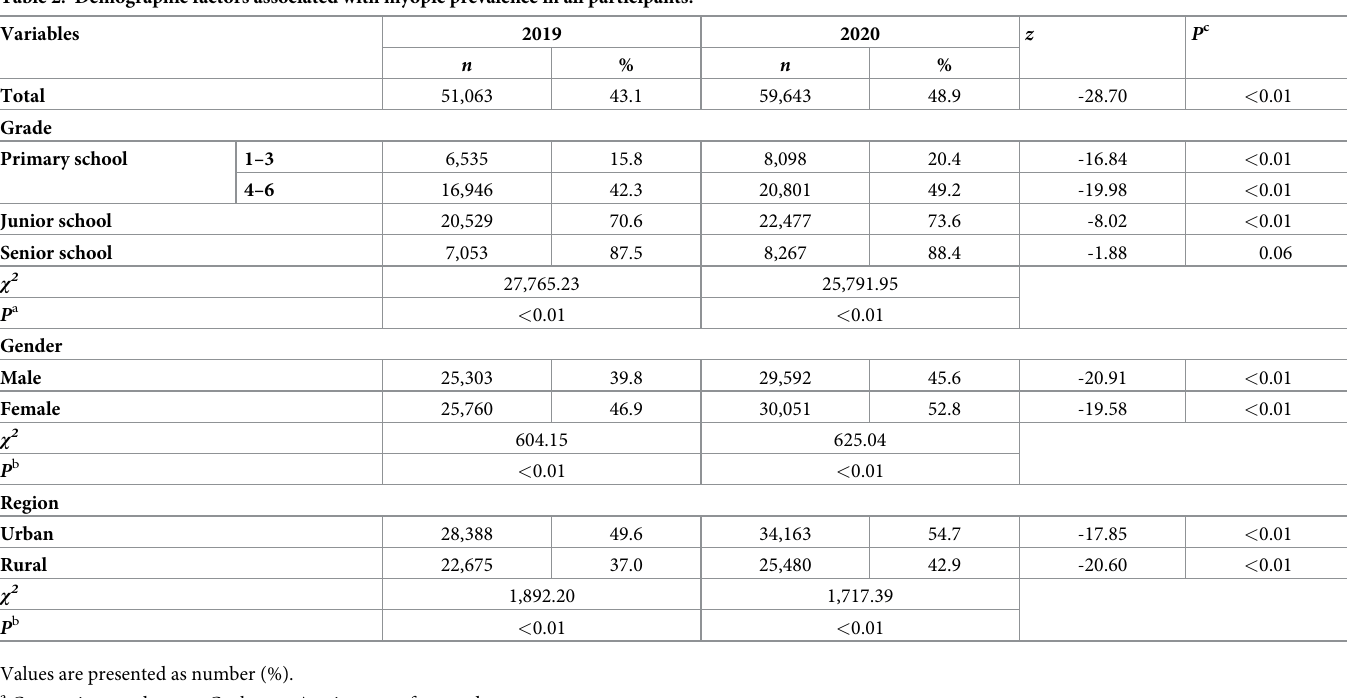
Comparison underwent Cochran—Armitage test for trends. b Comparison underwent Pearson’s chi-squared test. c Comparison underwent Two-proportions z